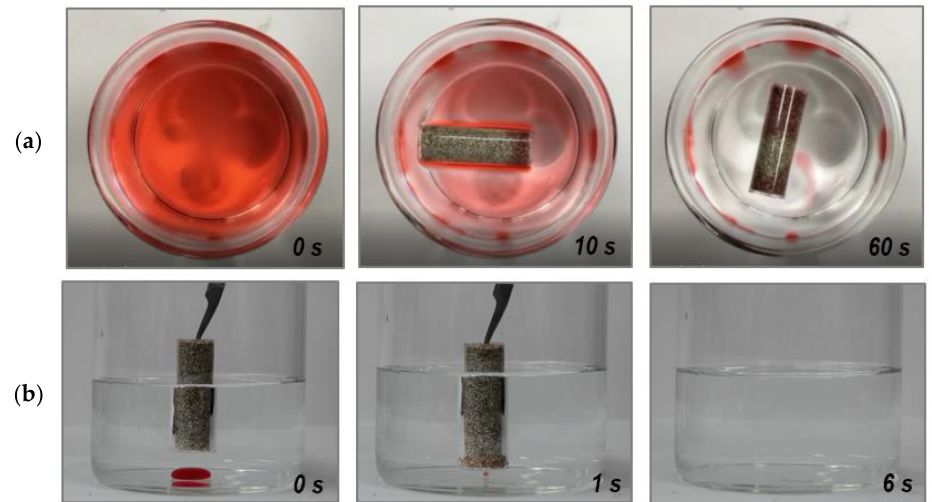
Figure 6. Snapshots taken at different times demonstrating the selective removal of ( a ) n -hexane column. The oils in ( a ) and ( b ) were stained with Oil Red